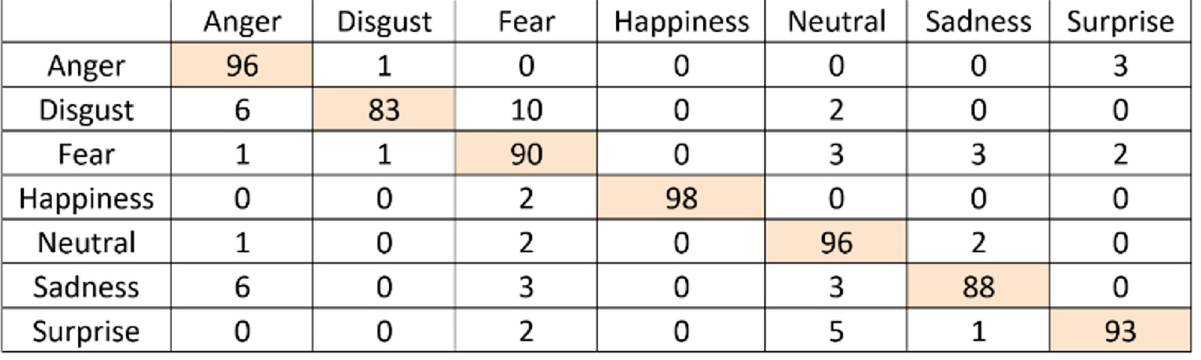
Fig 14. Confusion matrix for emotion recognition with the scoring system.